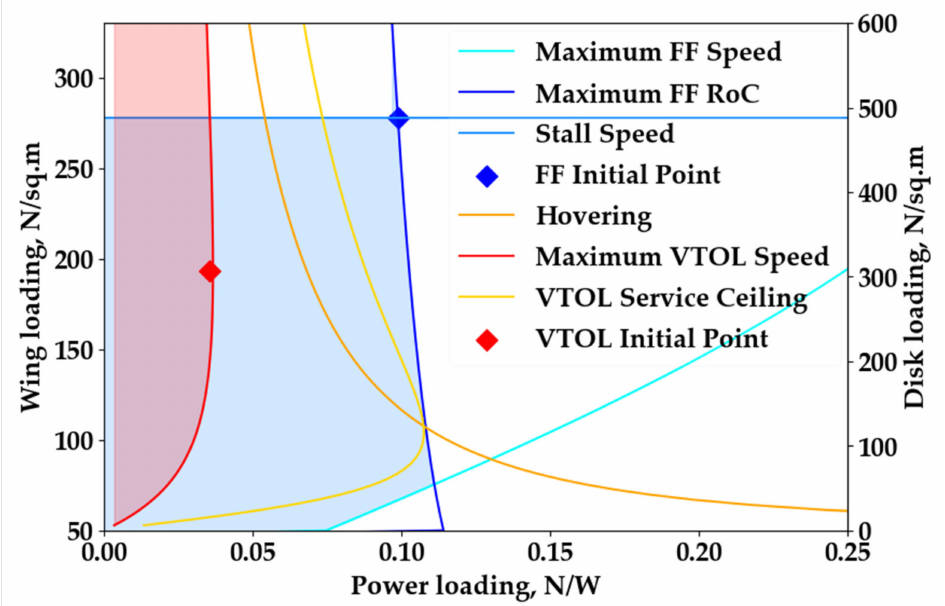
Figure 5. Example of multi-mode constraints